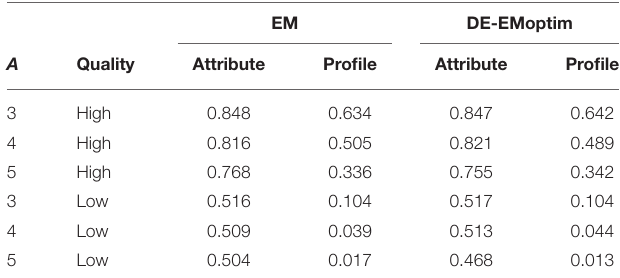
TABLE 3 | attribute accuracy rate of the simulation